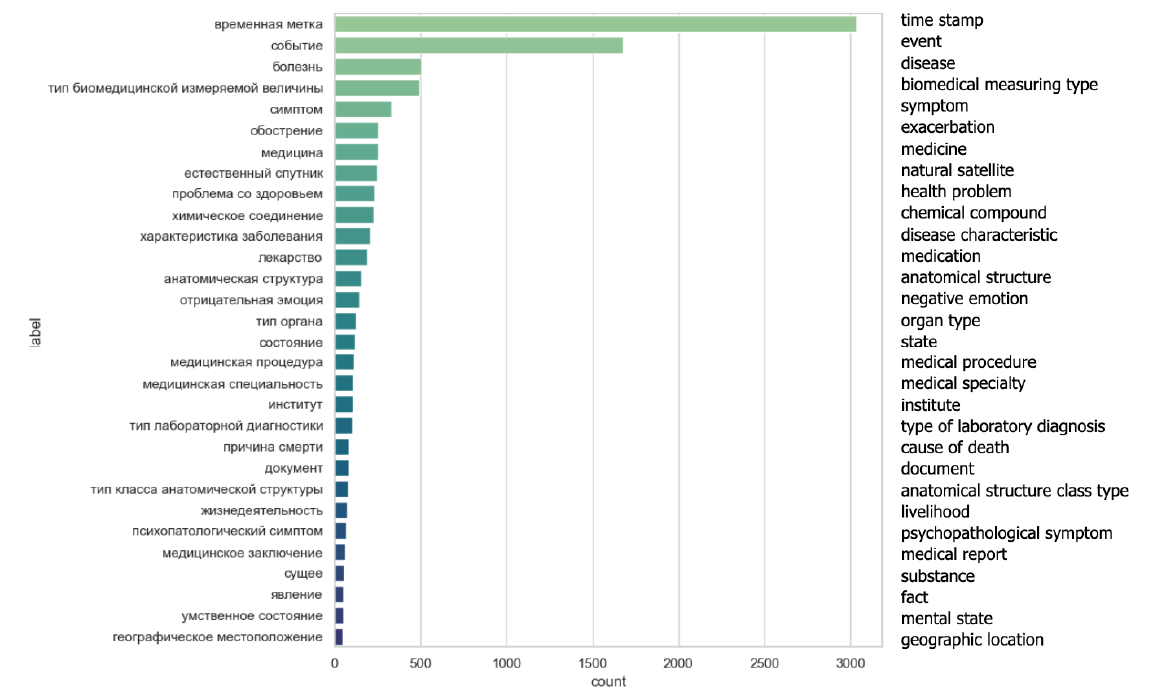
Figure 13. Bar charts with frequency statistics: ( a ) A bar chart with a number of groups with an equal number of words in a repeat; ( b ) A bar chart with a number of groups with an equal number of repeats.